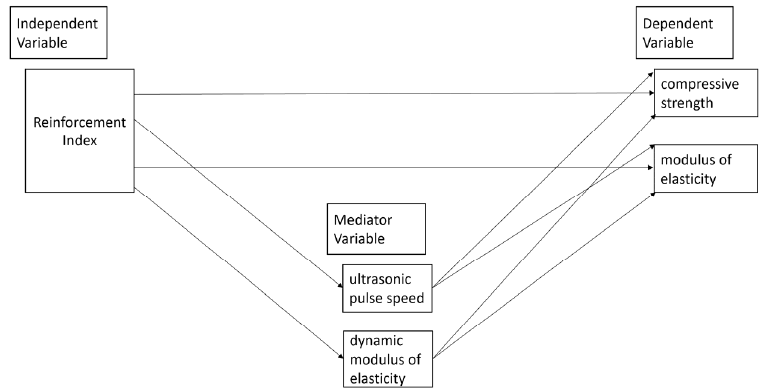
Figure 1. Experimental research design.